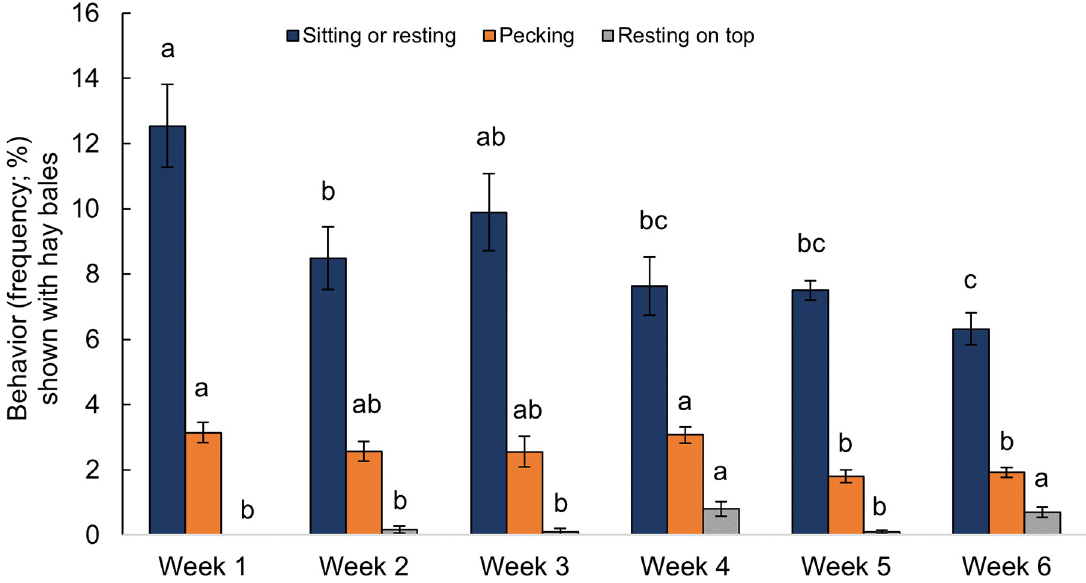
Fig 5. Frequency of observations (mean % ± SEM) of behaviors associated with the provided hay bale by age (in weeks) across two time periods (09:00 and 15:00 h). Sitting or resting by bale (n = 24), Pecking (n = 24), and Resting on top (n = 24). Frequencies without a common superscript ( a-c ) differed at P < 0.05.